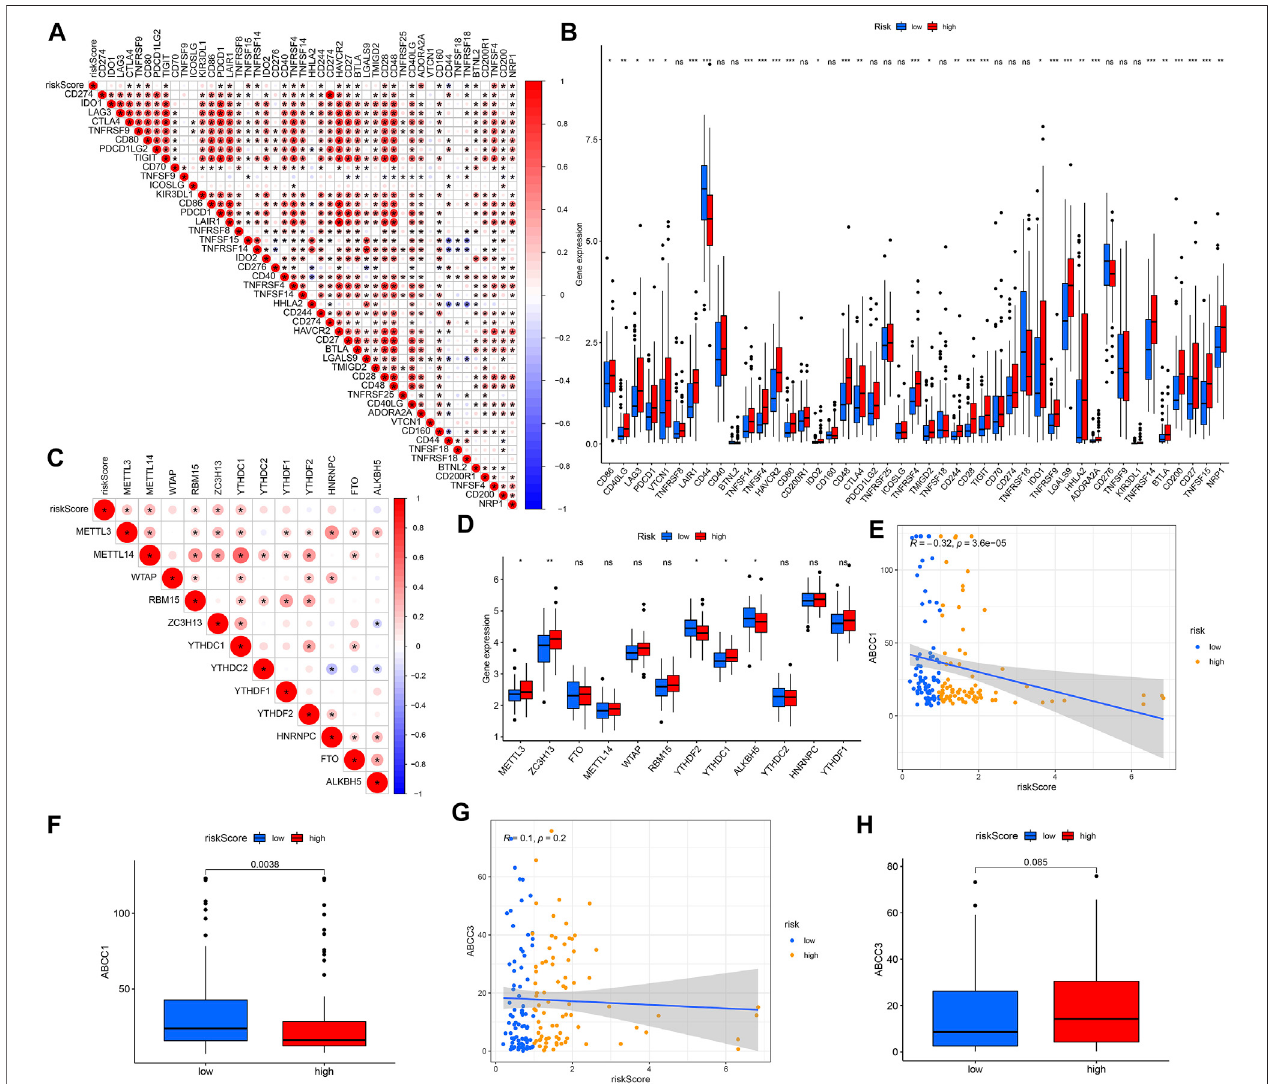
FIGURE 10 | Analyses of gene correlations. (A) Correlation analysis between 45 ICIs-related gene expression and risk score. (B) Expression levels of ICIs-related genes for high- and low-risk groups. (C) Correlation between m6A-related genes and risk score. (D) Expression of m6A-related genes for high- and low-risk groups. (E) Correlation between ABCC1 gene expression and risk score. (F) Expression levels of ABCC1 for high- and low-risk groups. (G) Correlation between ABCC3 expression and risk score. (H) Gene expression of ABCC3 in high- and low-risk groups. ns, not signi fi cant; * p < 0.05; ** p < 0.01; *** p <